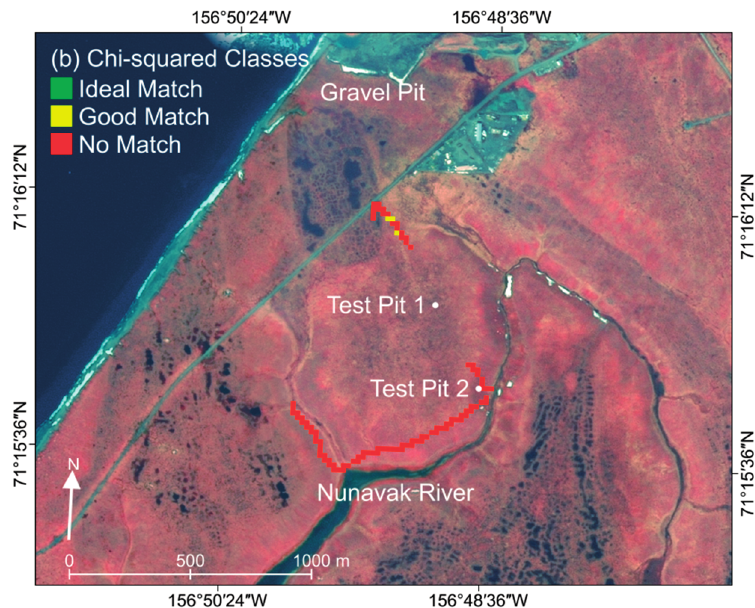
Figure 9. Residuals ( a ) and χ 2 classes ( b ) between the GPR ALT and ReSALT at the Nunavak River Site. The site consists of well-drained soils in the upper Nunavak drainage